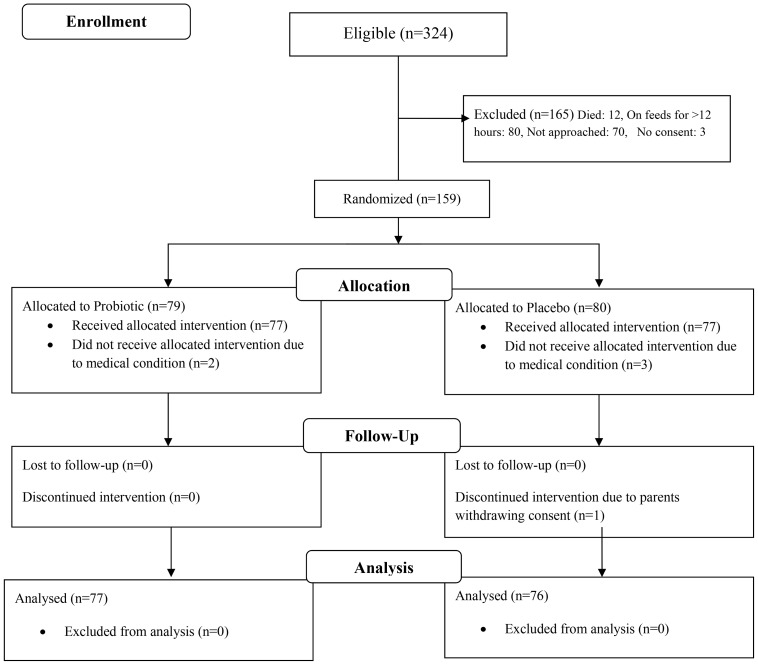
CONSORT Flow Diagram.